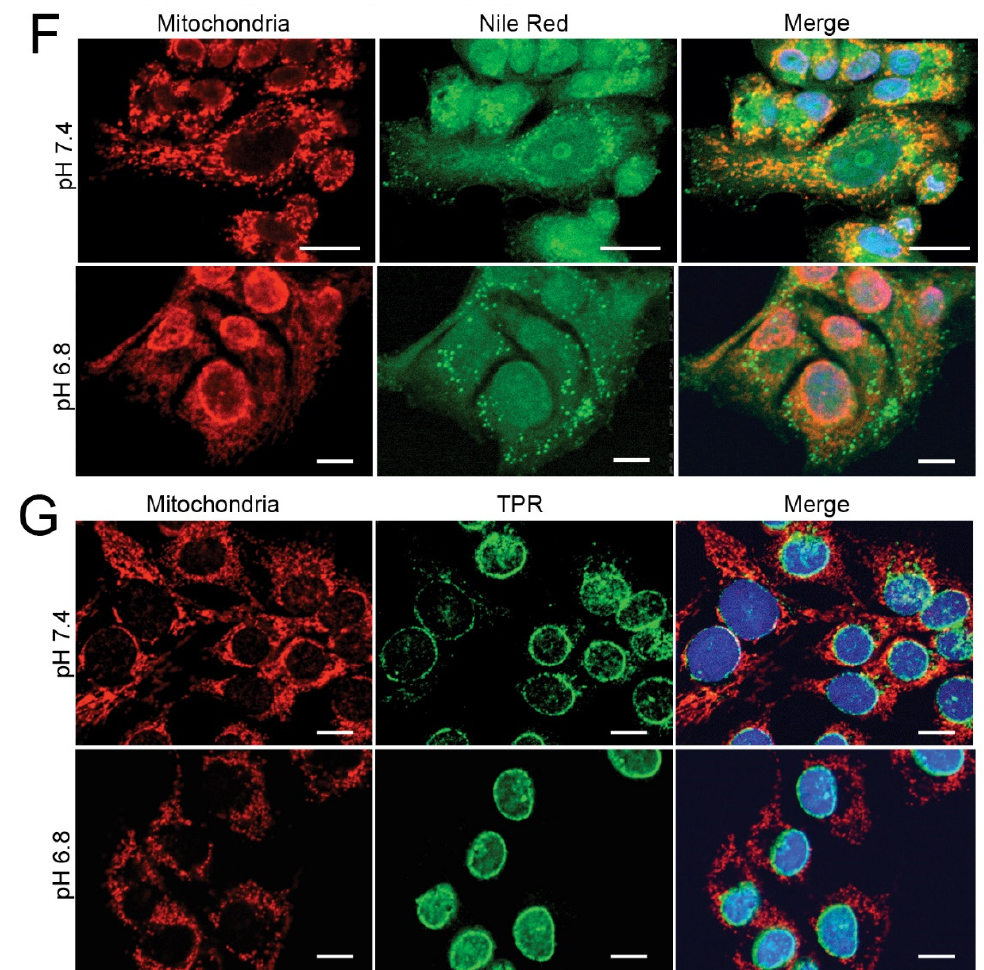
Figure 2. Mitochondria have low oxygen consumption and β -oxidation rates and relocalize to perinuclear regions under acidity. ( A ) OCR of monolayer 143B tumor cells chronically adapted to acidosis expressed as pmol O 2 /min normalized to protein content under basal conditions and after the injection of oligomycin, carbonyl cyanide 4-(trifluoromethoxy) phenylhydrazone (FCCP), rotenone or antimycin A. Graph shows OCR after antimycin A subtraction, to ensure removal of non-mitochondrial oxygen consumption. To evaluate β -oxidation of intracellular pool of fatty acids, 40 µ M etomoxir was added to the cells 15 min prior to measuring the OCR. The graph shows a representative experiment; ( B ) Graph shows basal respiration in the presence or absence of etomoxir. Data are presented as the mean ± S.E.M. of n = 12 from 3 independent experiments; unpaired two-tailed Mann-Whitney test; * p < 0.05, ** p < 0.01 for etomoxir vs untreated, # p < 0.01 for untreated acid vs untreated neutral; ( C ) Real Time PCR analysis of the indicated genes normalized to four housekeeping genes (HKG; GAPDH, GUSB, RNA18S, and YWAHZ) in 143B spheroids cultured for 96 h Data presented as mean ± S.E.M. of n = 6 RNA samples from 3 independent experiments; unpaired two-tailed Mann-Whitney test; * p < 0.05, ** p < 0.01 for acid vs neutral; ( D ) Number of mitochondria/cell. Mitochondria in 143B cell spheroids cultured for 96 h were counted from EM images with 2 µ m scale bar. Data presented as mean ± S.E.M. of n = 7 different fields from 3 independent experiments; unpaired two-tailed Mann-Whitney test; *** p < 0.001; ( E ) Mitochondrial diameter was measured from EM images with 2 µ m scale bar in 143B cell spheroids cultured for 96 h Data presented as mean ± S.E.M. of n = 9 different fields from 3 independent experiments; unpaired two-tailed Mann-Whitney test; *** p < 0.001; ( F ) Immunostaining of mitochondria (anti-surface mitochondria, red) with LD (Nile Red, green) in monolayer 143B tumor cells chronically adapted to acidosis. Nuclear staining with Hoechst (blue). Scale bar: 20 µ m; ( G ) Immunostaining of monolayer 143B tumor cells chronically adapted to acidosis: staining of mitochondria (anti-surface mitochondria, red) with the nucleoprotein TPR (green). Nuclear staining with Hoechst (blue). Scale bar: 20 µ